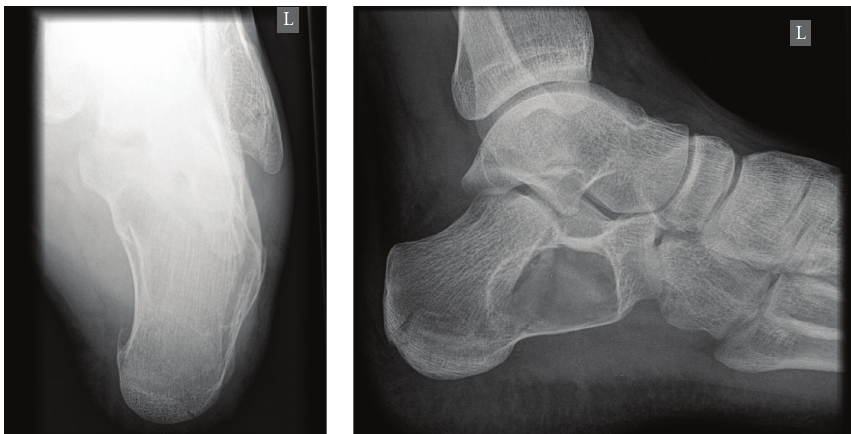
Figure 1: Axial and lateral plain X-rays showing a large radiolucent area in the anterior half of the calcaneal body resembling to a cyst. The lines of the pathologic fracture can also be observed.